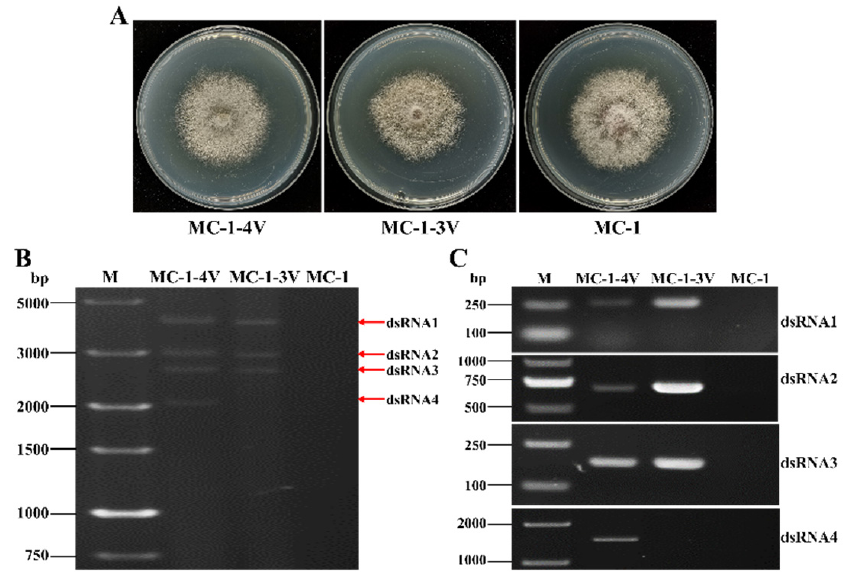
tract obtained by cellulose column chromatography from strains BH3, BH19-3V and BH19-4V. ( D ) The detection of each segment of FoAV1 in strains BH3, BH19-3V and BH19-4V by RT-PCR amplification.